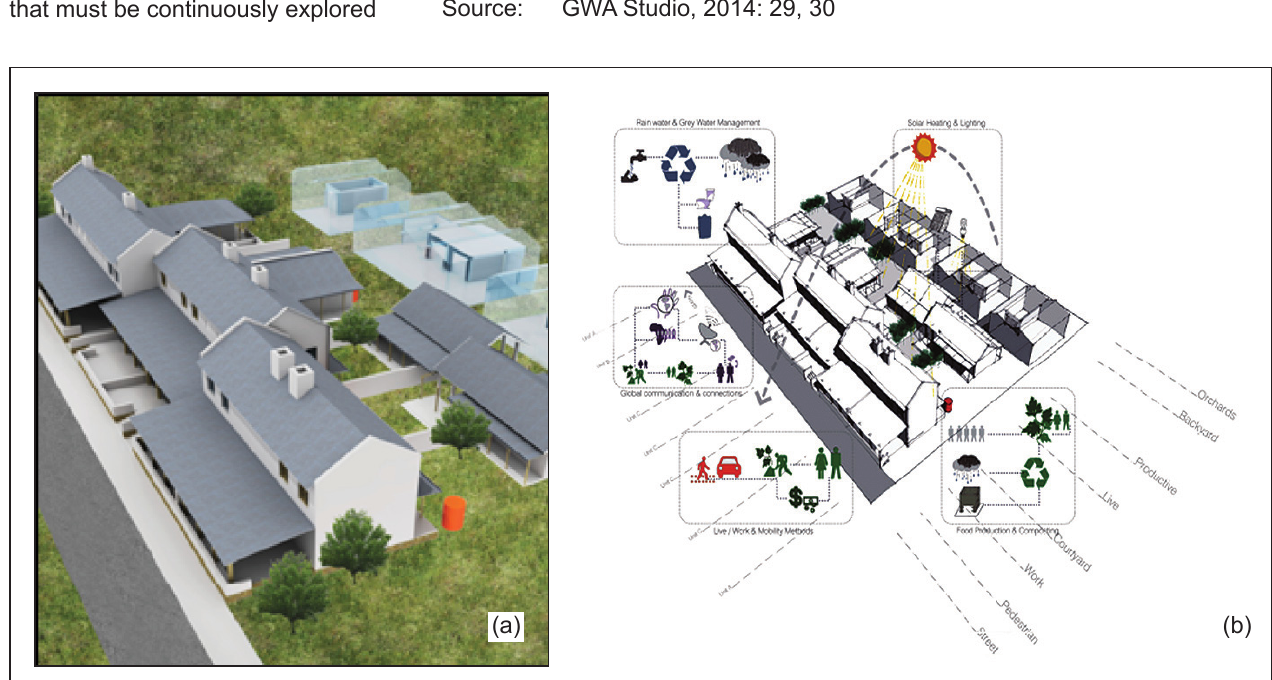
Housing typologies illustrating a symbiosis between building and